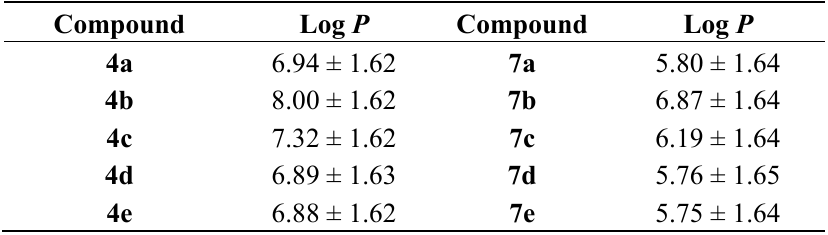
Table 3. Hydrophobicity parameters (log P ) of the purpurinimides calculated by means of computer software ACD/Labs (version